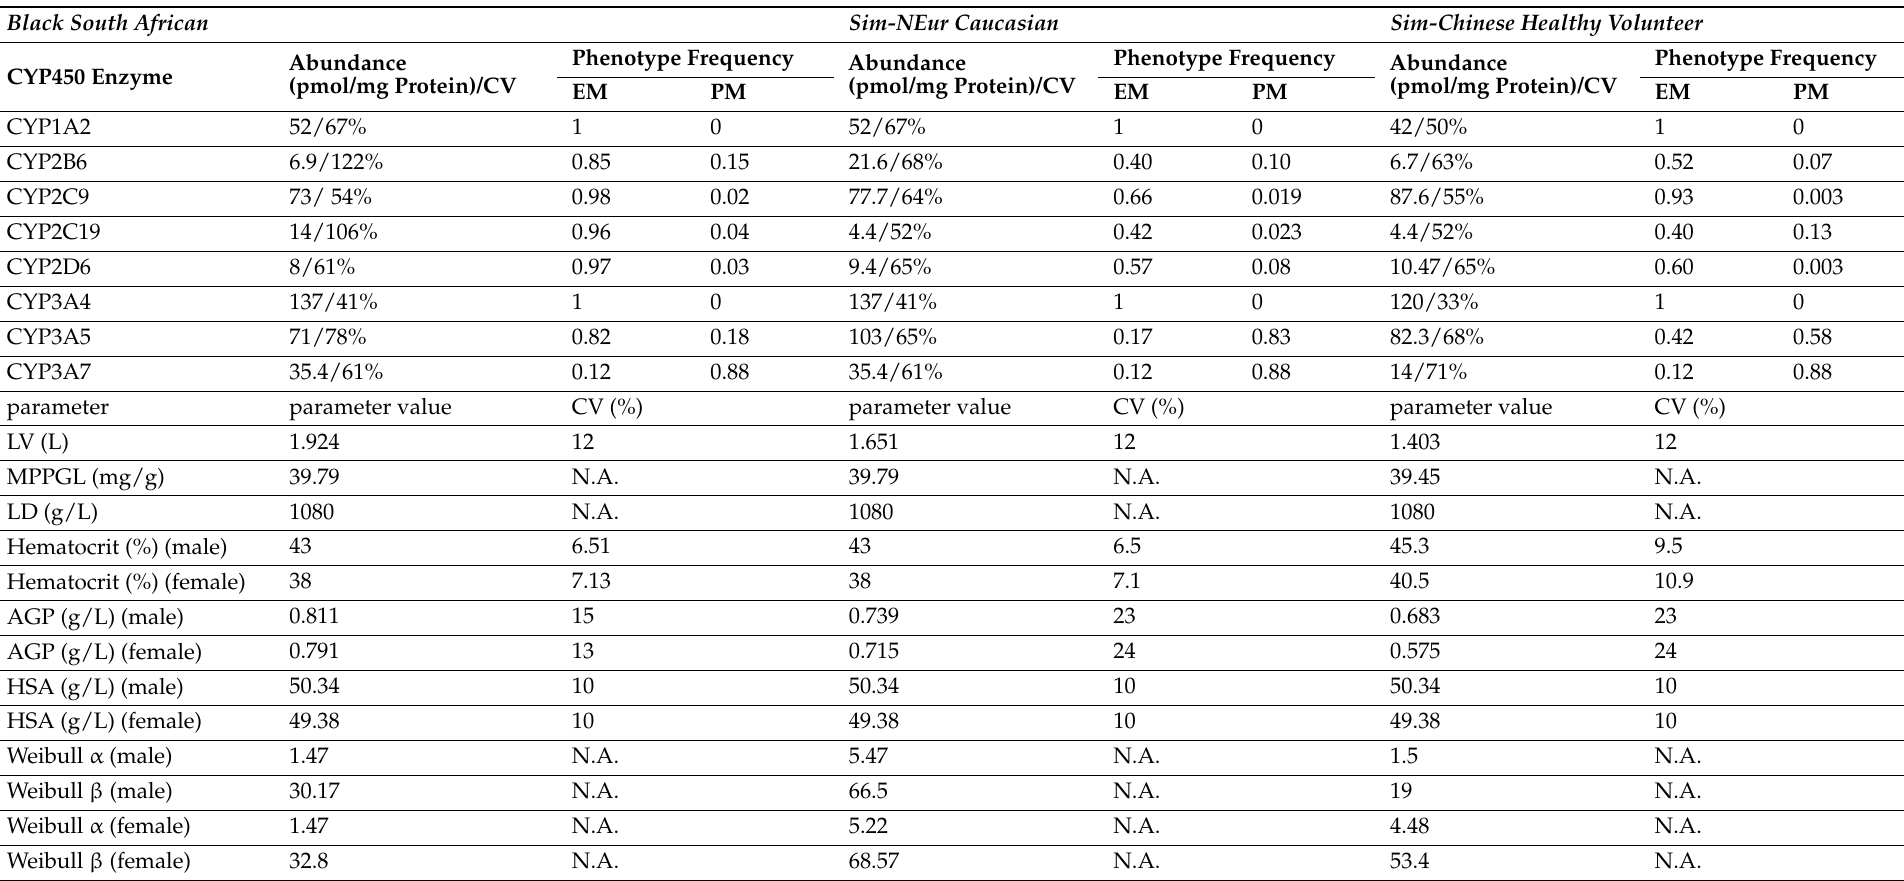
Table 3. A summary of CYP450 abundances and phenotype frequency for eight CYP450 enzymes and of selected parameters in the Black South African population, Sim-NEur Caucasian population and Sim-Chinese healthy volunteer